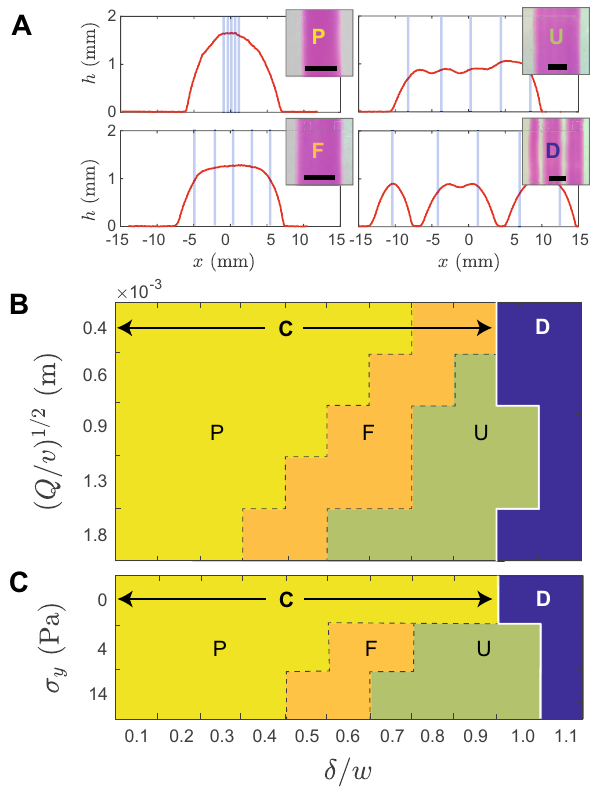
Figure 3. ( A ) Depending the overlap ratio δ/ w of printed lines (here 5 lines), different morphologies of the deposit are observed: discontinuous (D) or continuous, with undulating (U), flat (F) or parabolic (P) profiles 7 m 2 , and δ/ w 8.310 1.1, 0.8, 0.5 and 0.1 respectively. The blue vertical lines indicate the position ( Q / v − = = of the print path). The cartography of these morphologies depends on the on the overlap ratio δ/ w and 4 Pa) ( B ) and also on the yield-stress σ printing parameters Q / v (fixed yield-stress σ y = 7 m 2 ) ( C 8.310 Q / v − =